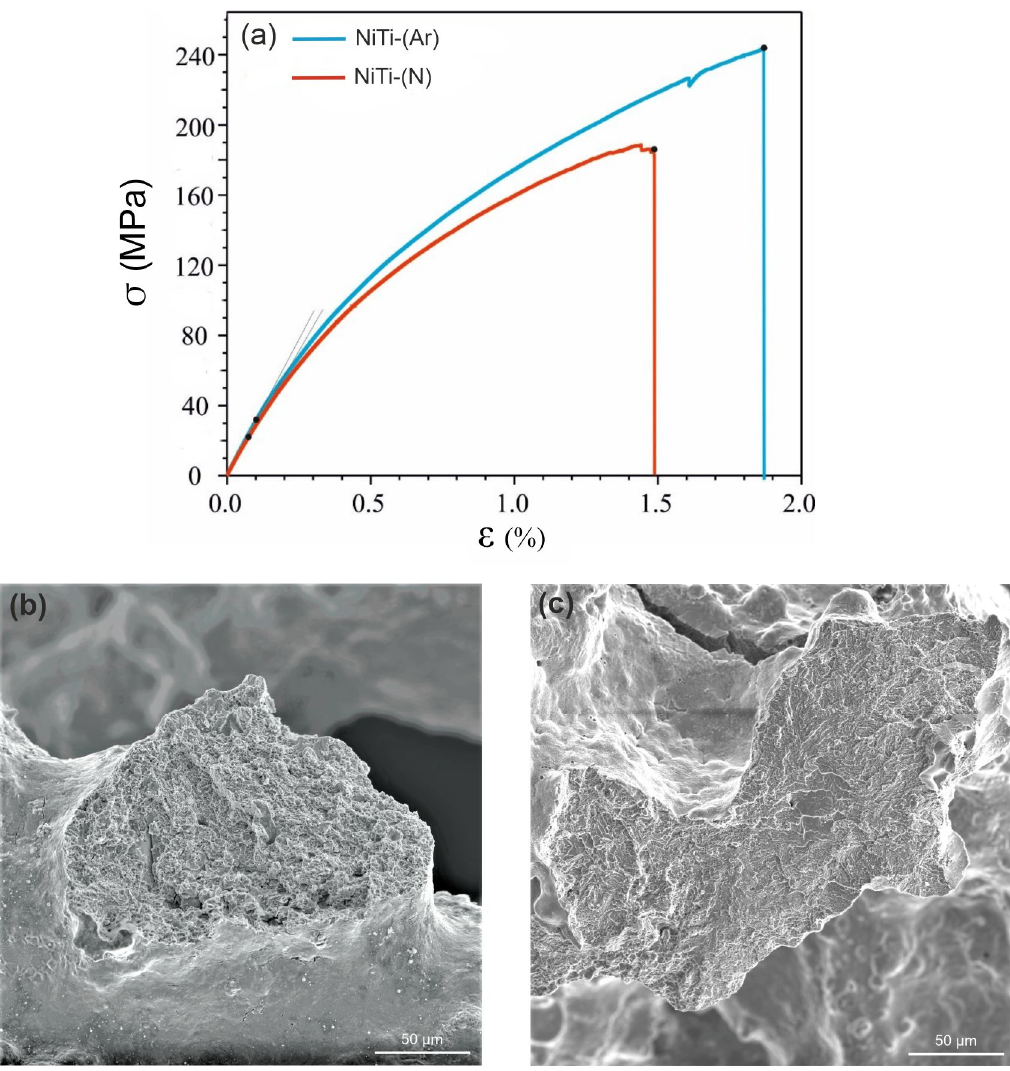
Figure 13. Deformation diagrams obtained during uniaxial tension of porous NiTi plates 20 × 12 × 5 mm 3 in size ( a ), general view of the interpore bridge fractogram of the porous NiTi-(Ar) ( b ) and NiTi-(N) ( c ) plates. Table 5. Mechanical properties of porous NiTi-(Ar) and NiTi-(N) samples.